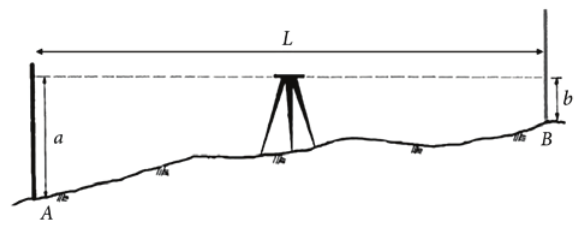
Figure 6. Measuring road gradient using level